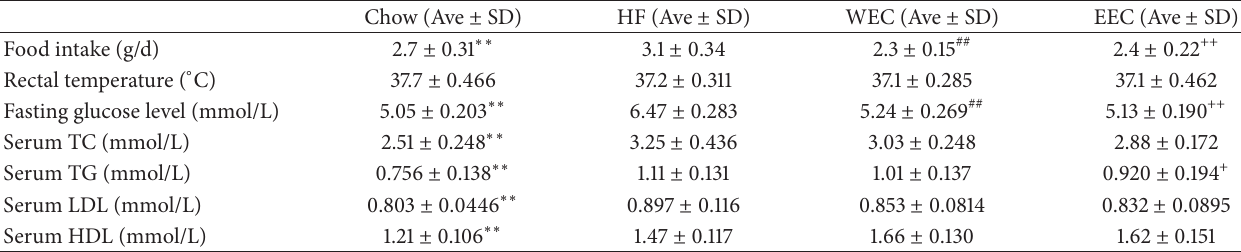
Table 2: The food intake, body temperature, and serum glucose and lipid profiles in the